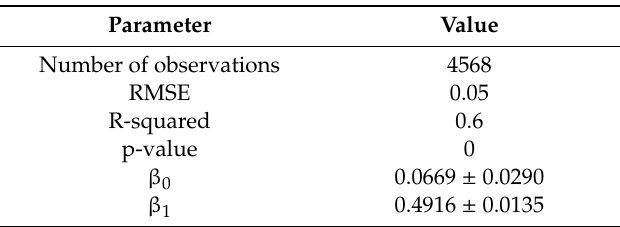
Figure 11. In ( a ) we see the location of the validation SPs (CYGNSS ∩ SMAP) for April 2019 (days shown in Figure 5). In ( b ), the scatter-plot shows the SMAP estimates versus the CYGNSS estimates of SMC [cm 3 · cm − 3 ]. Parameters of the regression model are shown in Table 1. Northern regions (summer monsoon and dry winter, Cwa) are in blue and southern regions (without dry season, Cfa) are in red. Table 1. Linear robust regression model of least absolute residual method: “SMC SMAP = β 0 + β 1 · SMC CYGNSS ”. The corresponding scatter-plot is shown in Figure